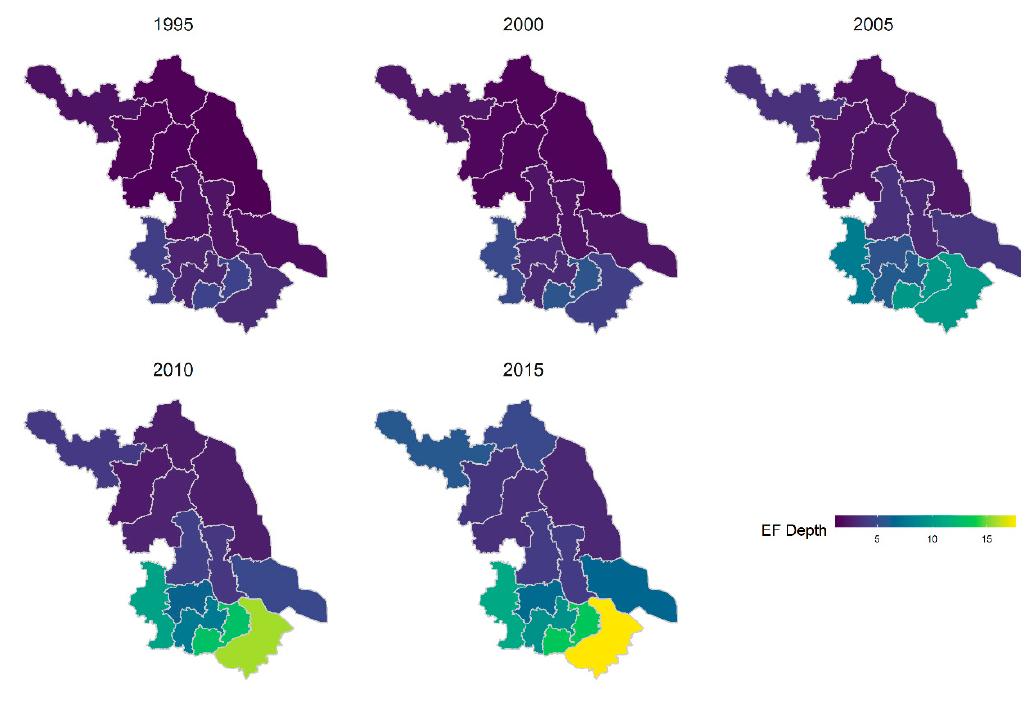
Figure 3. Jiangsu’s city-level ecological footprint depth from 1995–2015. At the county scale, the three-dimensional map of the ecological footprint depth of each county in Jiangsu Province from 1995 to 2015 is shown in Figure 4 and Table A2. The overall spatial correlation also gradually increased in the study years. From the perspec- tive of spatial agglomeration, most of the counties are low-EFD agglomeration areas, which are distributed in the northern and central parts of Jiangsu, and high-EFD agglom- eration areas are mainly distributed in southern Jiangsu. Due to the process of urbaniza- tion, the population is gradually agglomerating in urban areas, and high values are mainly distributed in urban areas of prefecture-level cities, showing a very high EFD that was significantly higher than that of non-urban territorial units.